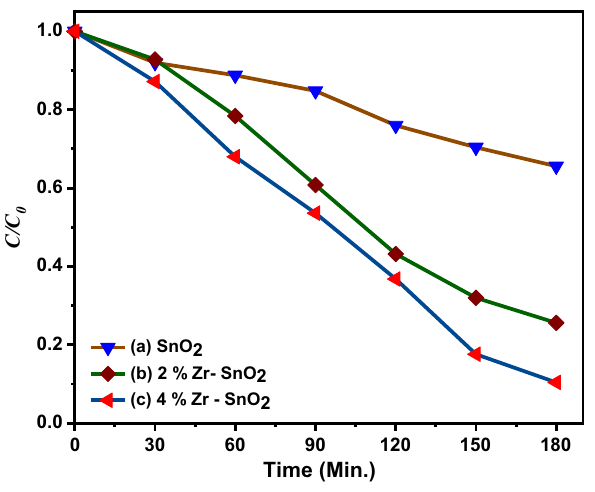
Time (Min.) Fig. 10 First-order kinetic plot for the degradation of MO over (a) 2 , (b) 2% Zr-doped SnO 2 , (b) 2% Zr-doped SnO 2 NPs and (c) 4% Zr-doped SnO 2